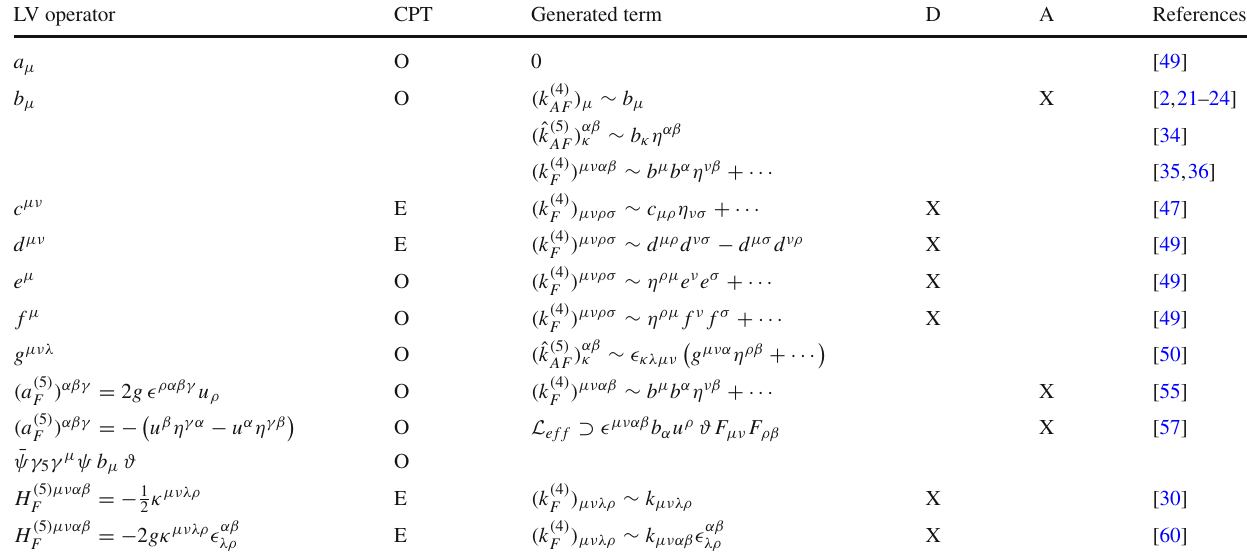
Table 1 Summary table of the generation of Lorentz-breaking opera- correction is actually Lorentz invariant, so it is not included in the trace- tors in the photon sector of the SME. Notice that CPT-odd coefficients lesscoefficient k F . The columns Dand A indicatewhether the diagrams can generate CPT-even corrections at second order. Also, the axion case generating the given operator are divergent or ambiguous, respectively (pseudo-scalar field ϑ ) is not written in SME notation since the induced LV operator CPT Generated term D